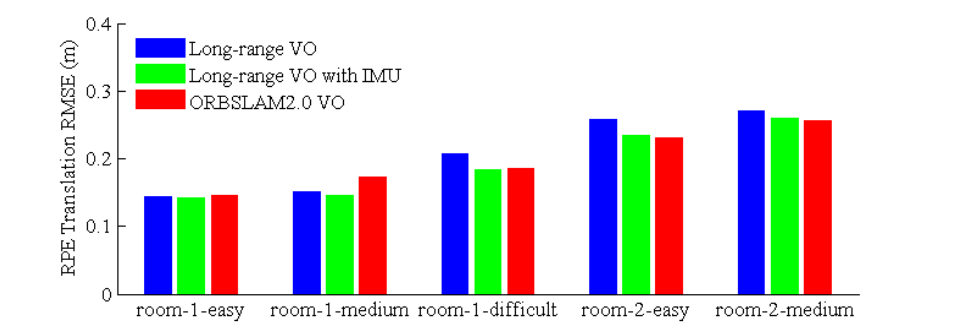
Figure 12. Relative Pose Error (RPE) evaluation